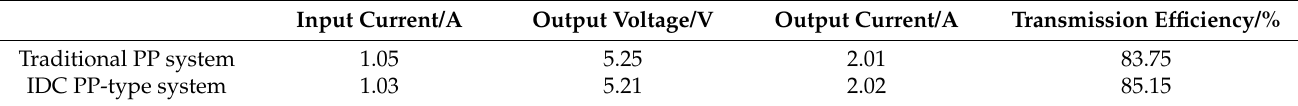
Table 3. Transmission efficiency data